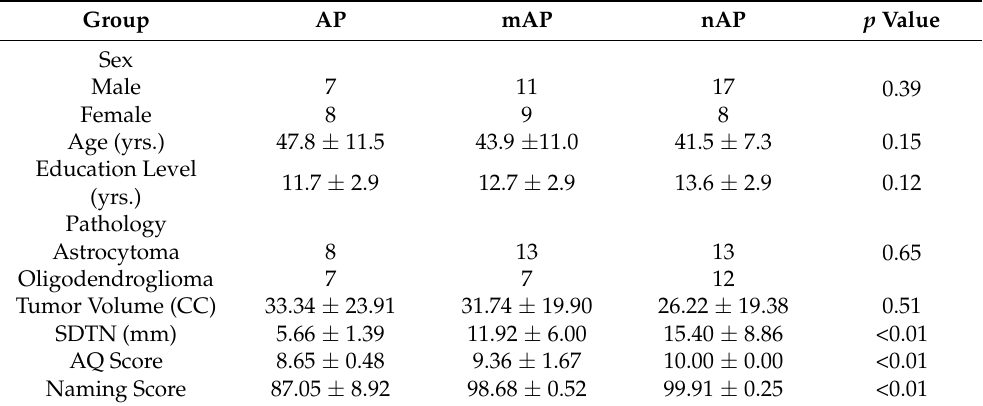
Table 1. Demographic